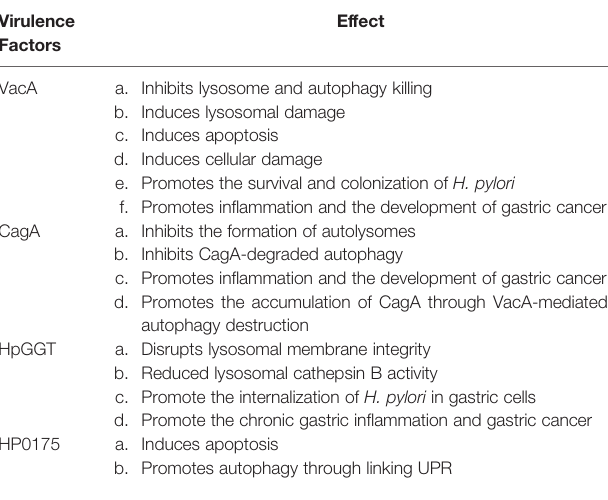
TABLE 1 | The effect of H. pylori virulence factors that induce autophagy in gastritis